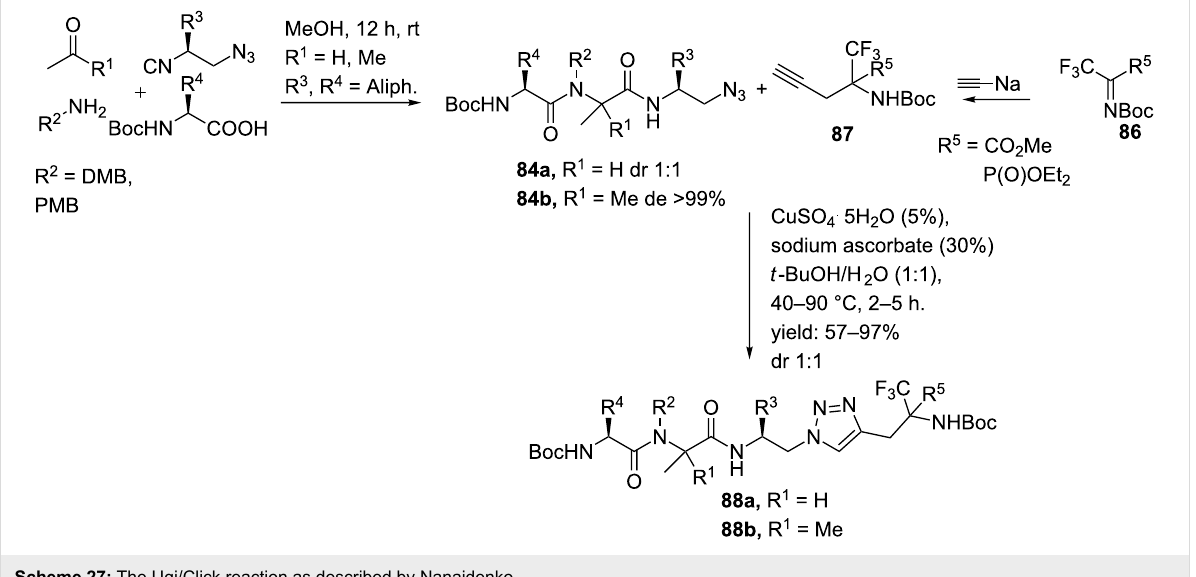
Scheme 27: The Ugi/Click reaction as described by Nanajdenko.